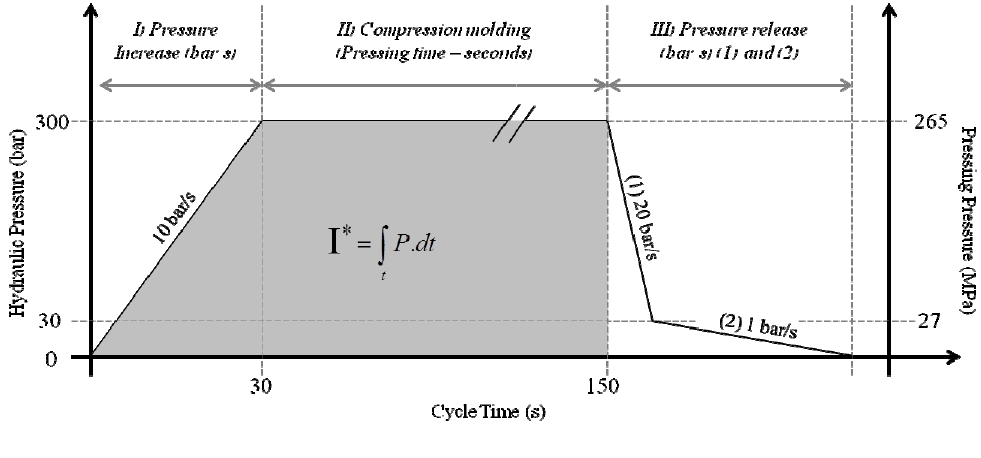
Figure 13. Typical press cycle for control conditions. The investigation of Time used different time of phase II. The investigation of Pressure Rate Increase impacted phase I. The integral I was taken constant for the Pressure Rate investigation